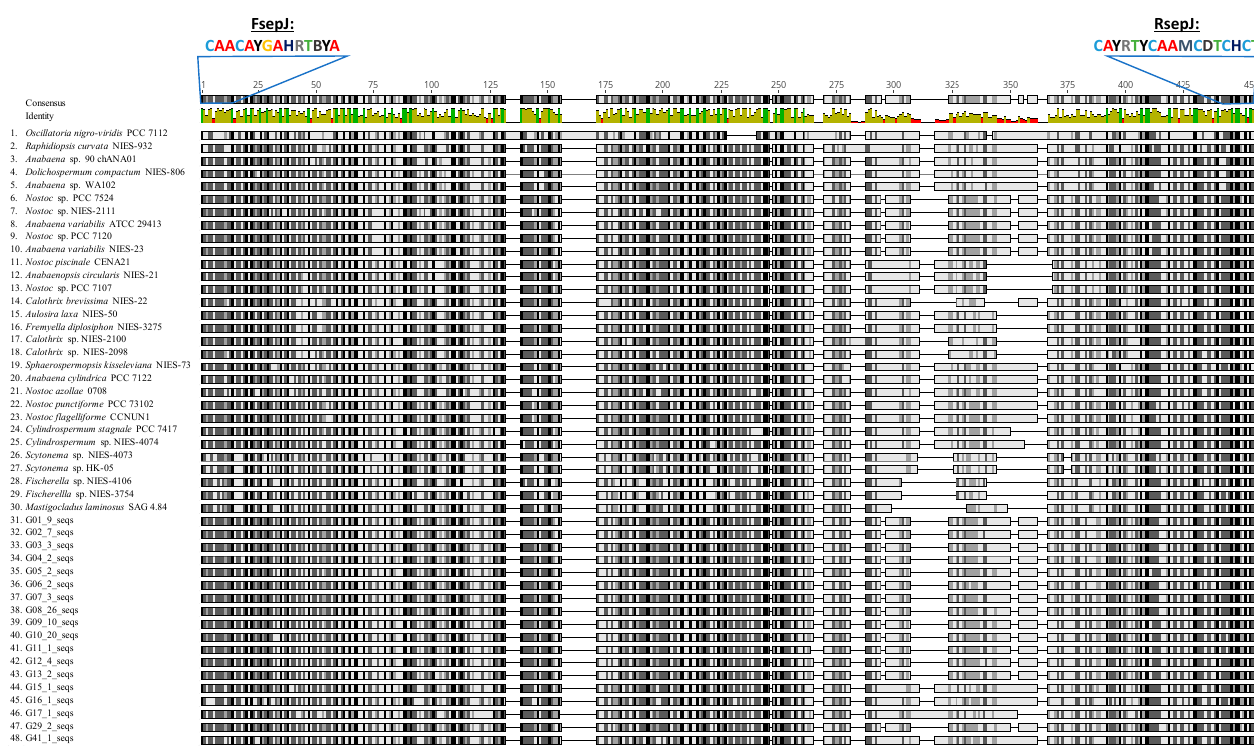
Figure 2. Alignment of the cyanobacterial sepJ sequences used for the genetic characterization of the cyanobacterial isolates and primers used for the amplification of the sequences. The genomic region contained a hypervariable region that was used to genetically trace the different cyanobacterial strains.